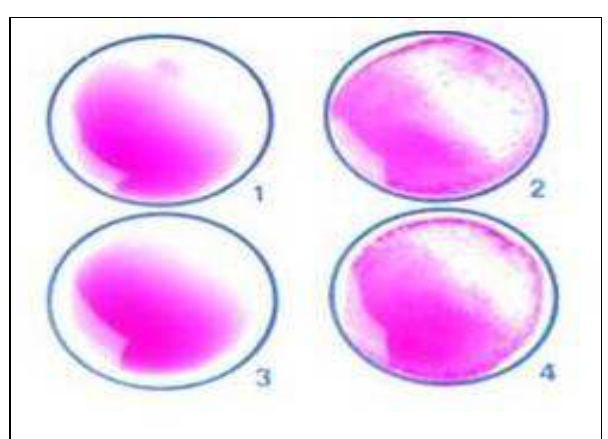
Figure-1: Map of study